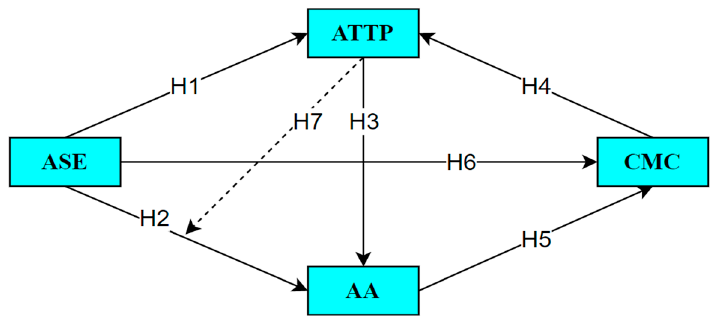
Figure 1. Hypothesized relationships of the research model [ASE = academic self-efficacy; AA = academic amotivation; ATTP = Attitude toward the teaching profession; CMC = classroom management concerns].